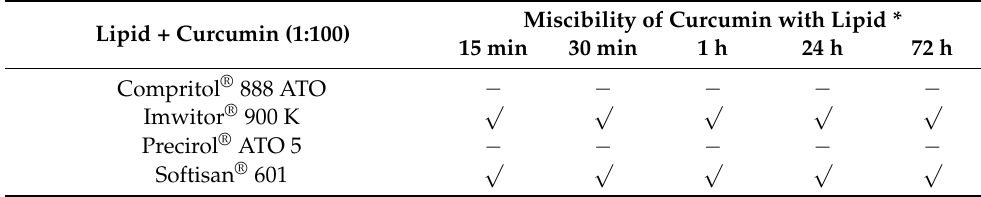
Table 1. Selection of lipids versus active ingredient (curcumin) based on the experiments run at 15 min, 30 min, 1 h, 24 h, and 72 h. Miscibility of Curcumin with Lipid Lipid + Curcumin (1:100)